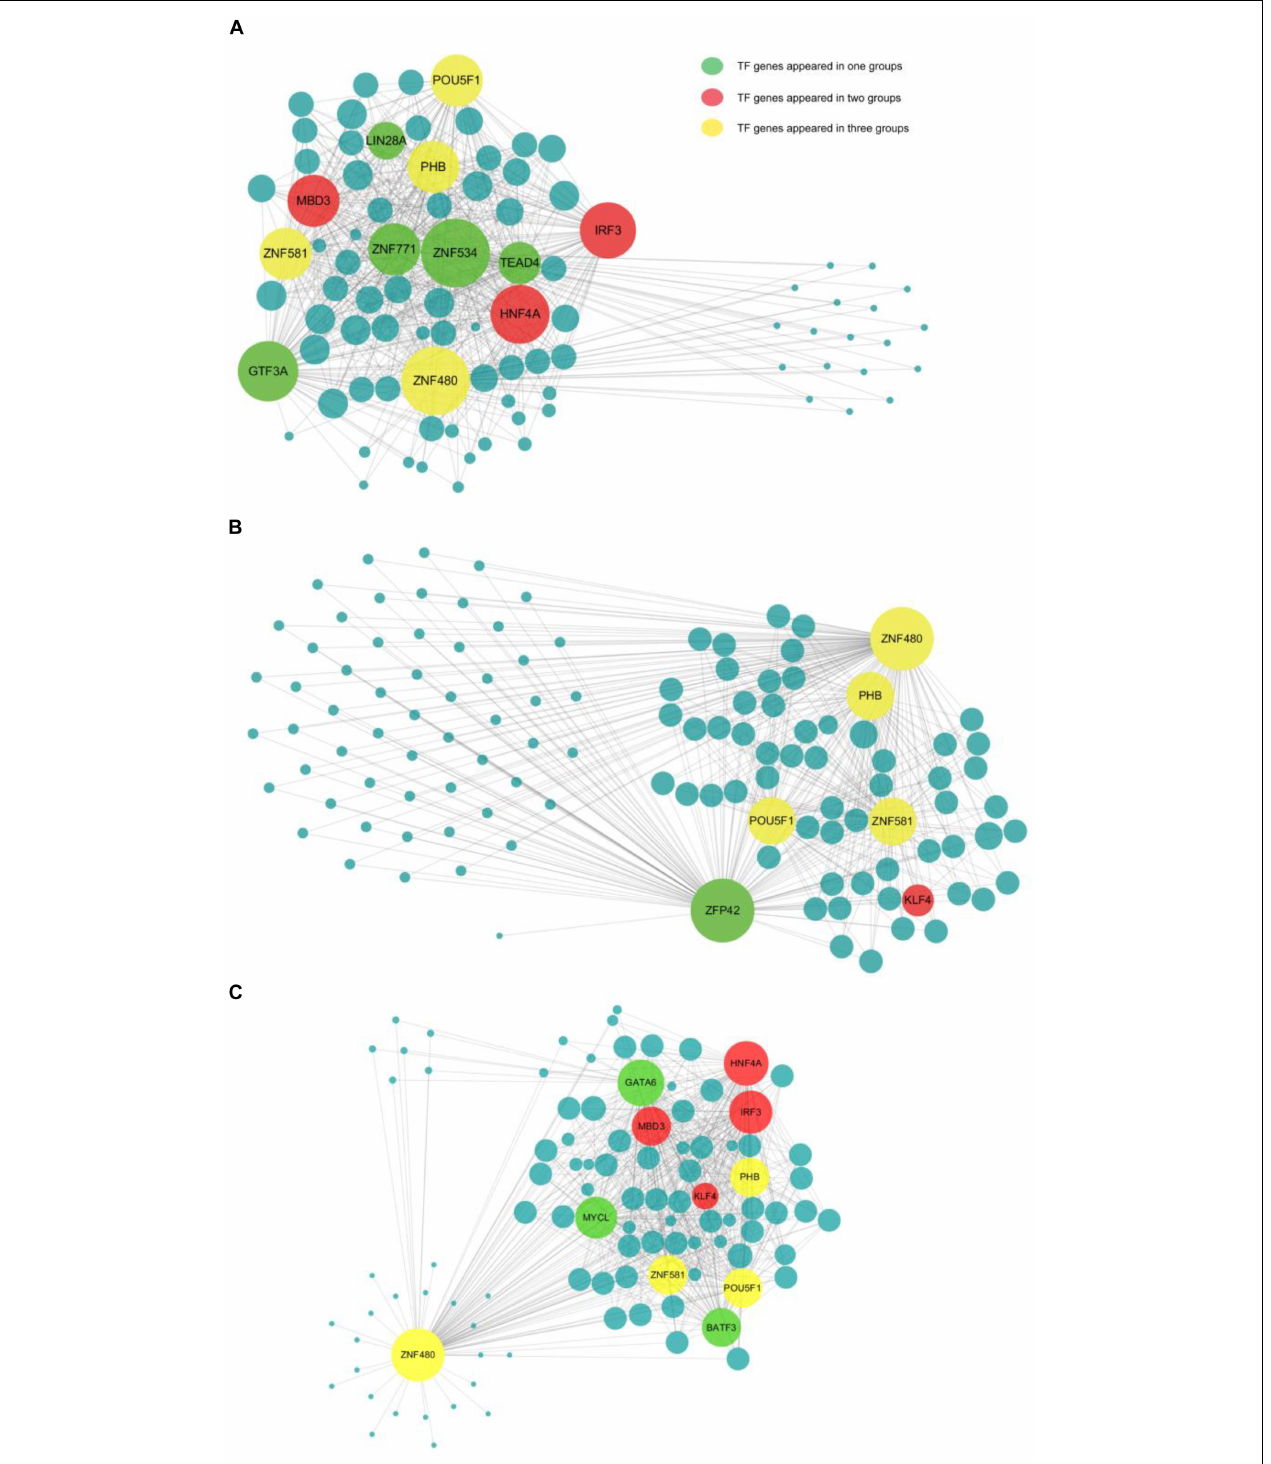
FIGURE 4 | The network information involved in biparental and uniparental embryos. The size of a node is related to the number of genes that interact with it. The more genes there are, the bigger the node. The line between two nodes shows the degree of interaction. The more correlation there is, the shorter the line. Yellow is used to show common TFs in all three groups; red is used to show common TFs in two groups; and green is used to show special TF in one group. (A–C) The network information involved in AG, PG, and BI embryos, showing the 12, 6, and 11 most important TFs together with their co-expressed target genes, respectively.